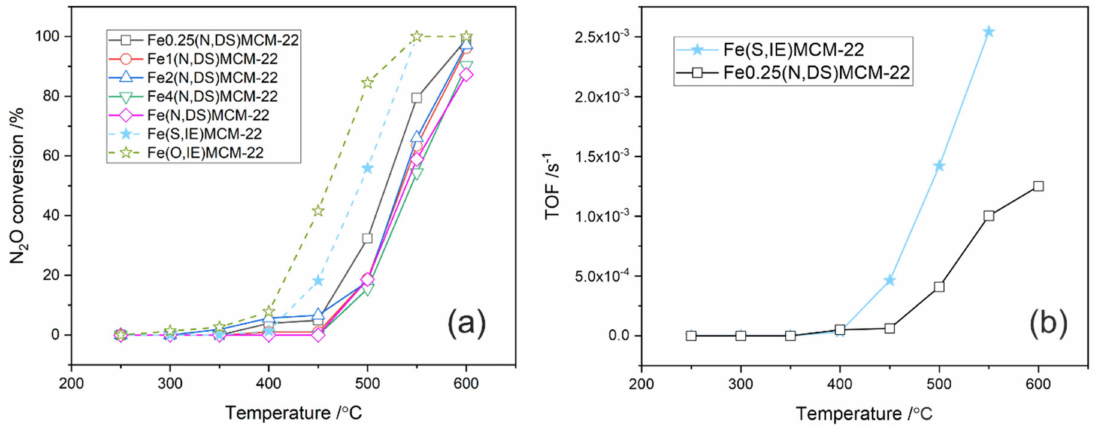
Figure 7. ( a ) Temperature dependence of N 2 O conversion over the samples from FeX(N,DS)MCM-22 series (modified with iron by direct synthesis), compared with the samples Fe(S,IE)MCM-22 and Fe(O,IE)MCM-22 (modified with iron by ion-exchange). ( b ) Temperature dependence of reaction rate for Fe(S,IE)MCM-22 and